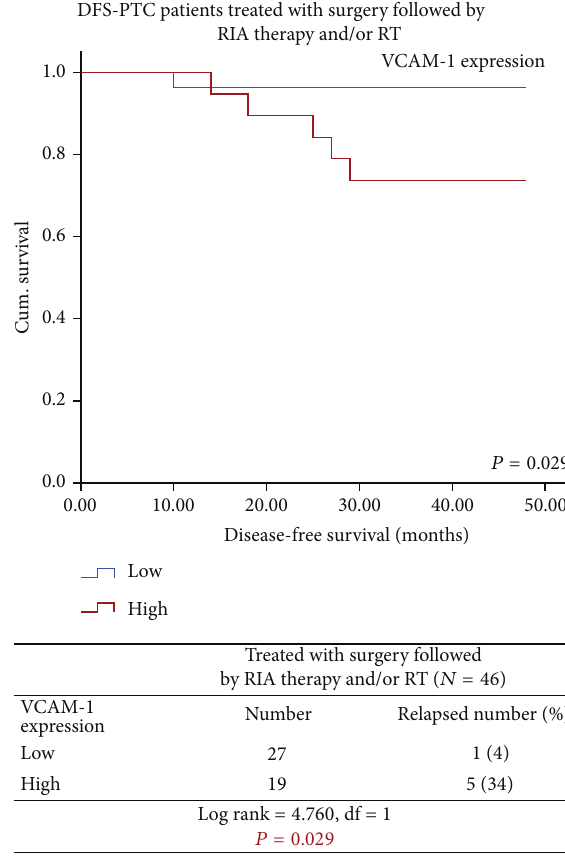
Figure 9: Significantly reduced DFS observed in PTC patients treated with surgery followed by RIA therapy and/or RT having high VCAM-1 expression as compared to those with low VCAM-1